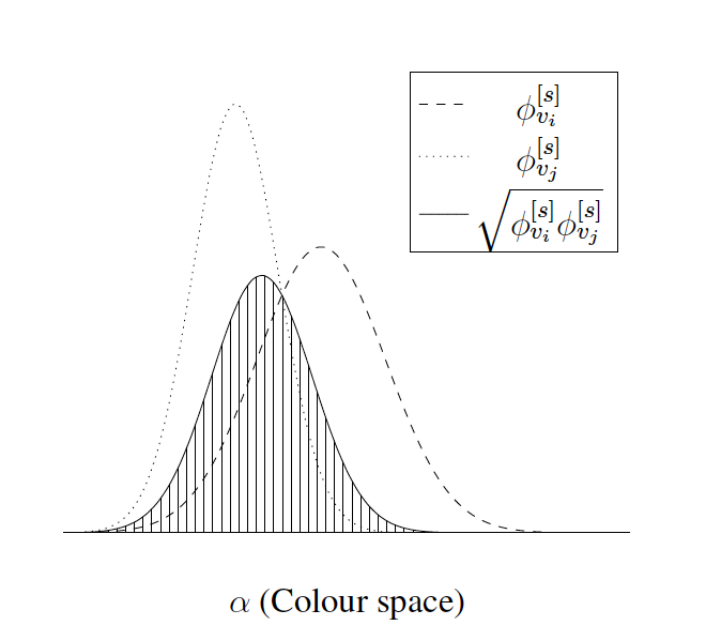
Figure 1. Visual representation of two functions φ [ s ] and the weighted W [ s ] (striped